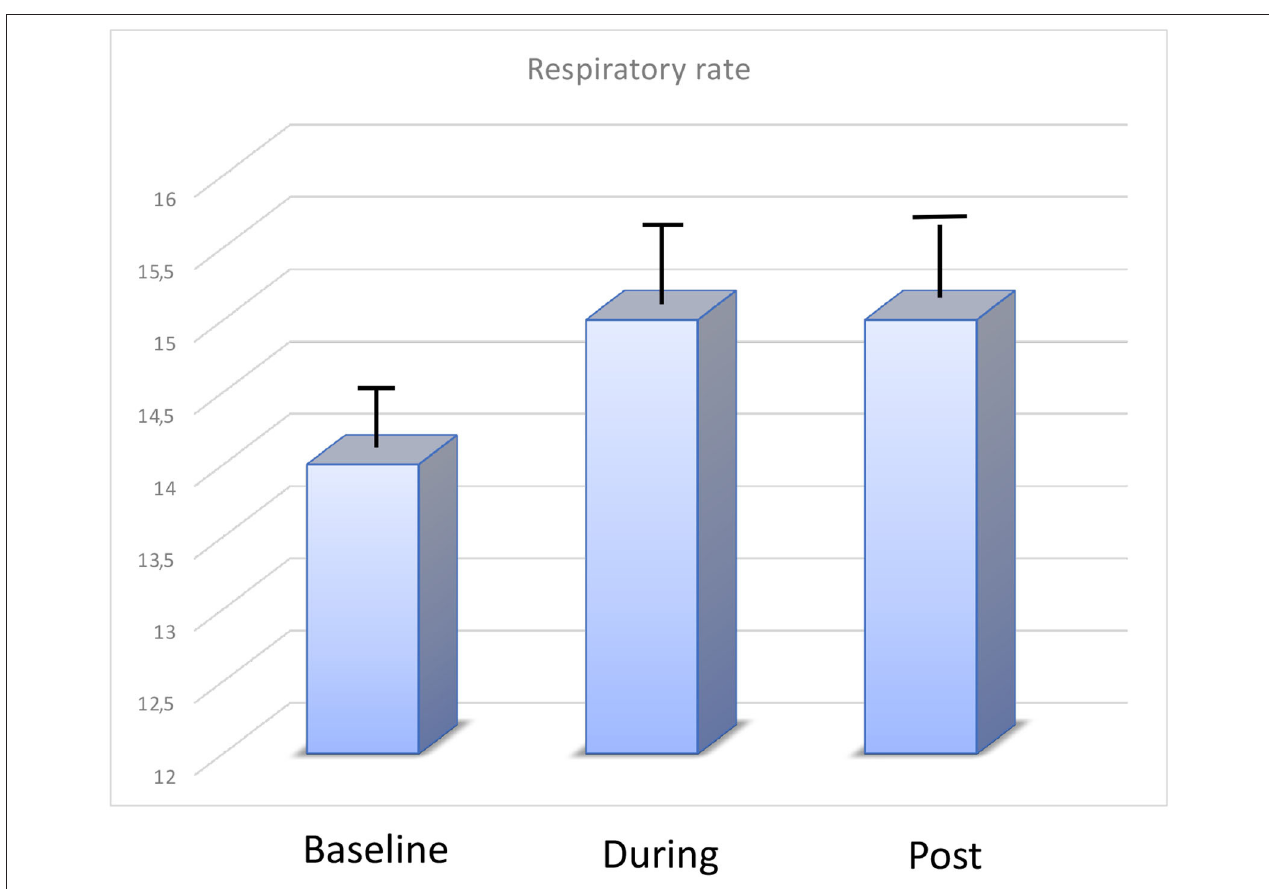
FIGURE 3 | Changes in respiratory rate (rpm) at baseline, during, and after